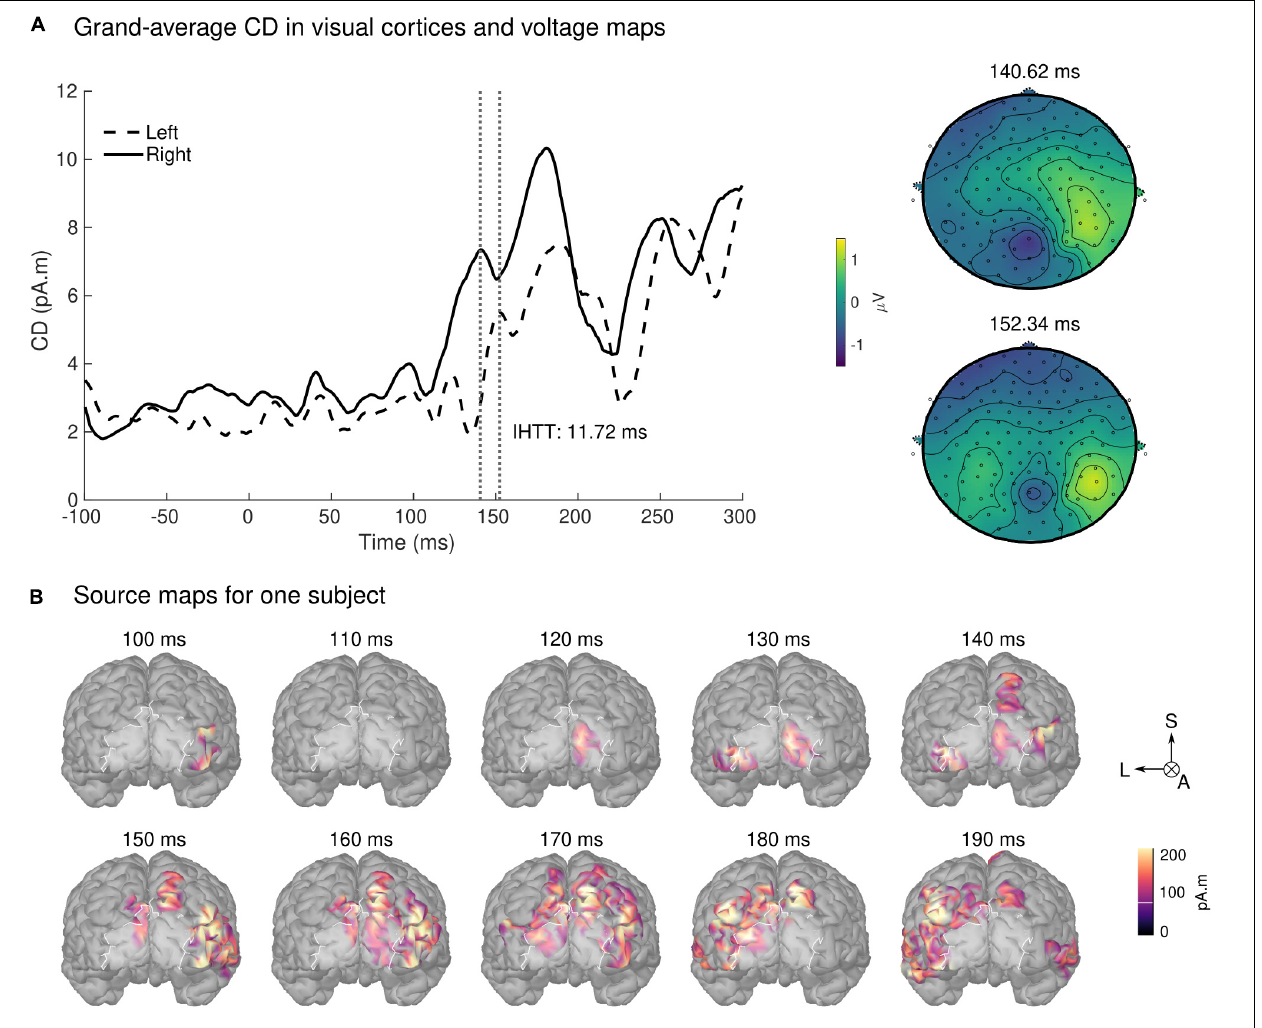
FIGURE 8 | Source space results. (A) Group averaged CD for the left visual field stimulation (left panel). The mean activation in the V1V2 ROI on the left and right hemispheres are shown in dashed and solid lines, respectively. Time 0 ms identifies the onset of the stimulus presentation. A first peak on the right hemisphere is observed between 100 and 145 ms, followed by a peak on the left hemisphere after 145 ms. Vertical lines identify the peaks of activation in both hemispheres. IHTT was calculated as the difference between the peak of activation on the hemisphere ipsilateral (left) and contralateral (right) to the stimulation visual field: 11.72 ms. The grand-average sensor level topographic voltage maps corresponding to the identified peaks are shown on the right panel. (B) Spatial distribution of the CDs of one exemplar subject projected on this subject’s cortex for the left visual field stimulation during the post-stimulus period. Highlighted in white is the V1V2 ROI of interest. For the sake of clarity, we show only groups of source values that contained more than 30 vertices and were 36% above minimal activation. L: Left; S: Superior; A: